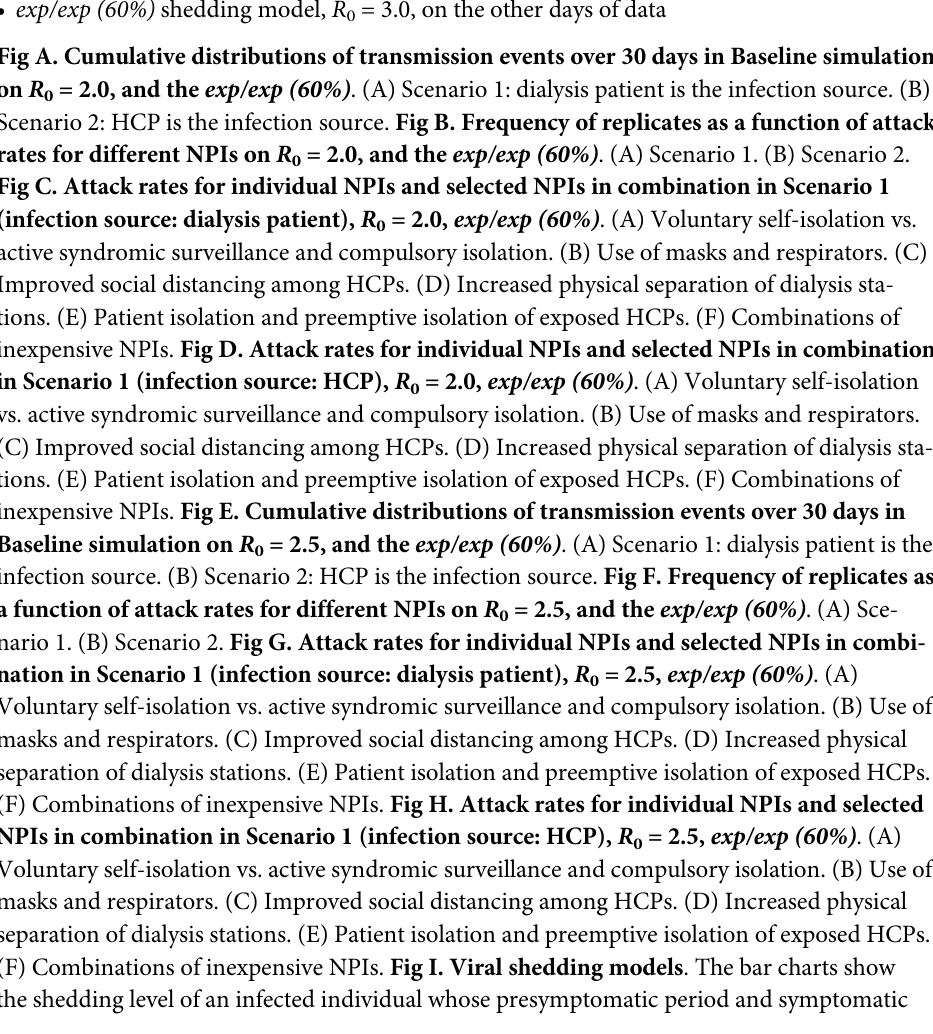
Fig A. Cumulative distributions of transmission events over 30 days in Baseline simulation on R = 2.0, and the exp/exp (60%) . (A) Scenario 1: dialysis patient is the infection source. (B) 0 Scenario 2: HCP is the infection source. Fig B. Frequency of replicates as a function of attack rates for different NPIs on R = 2.0, and the exp/exp (60%) . (A) Scenario 1. (B) Scenario 2. 0 Fig C. Attack rates for individual NPIs and selected NPIs in combination in Scenario 1 (infection source: dialysis patient), R = 2.0, exp/exp (60%) . (A) Voluntary self-isolation vs. 0 active syndromic surveillance and compulsory isolation. (B) Use of masks and respirators. (C) Improved social distancing among HCPs. (D) Increased physical separation of dialysis sta- tions. (E) Patient isolation and preemptive isolation of exposed HCPs. (F) Combinations of inexpensive NPIs. Fig D. Attack rates for individual NPIs and selected NPIs in combination in Scenario 1 (infection source: HCP), R = 2.0, exp/exp (60%) . (A) Voluntary self-isolation 0 vs. active syndromic surveillance and compulsory isolation. (B) Use of masks and respirators. (C) Improved social distancing among HCPs. (D) Increased physical separation of dialysis sta- tions. (E) Patient isolation and preemptive isolation of exposed HCPs. (F) Combinations of inexpensive NPIs. Fig E. Cumulative distributions of transmission events over 30 days in Baseline simulation on R = 2.5, and the exp/exp (60%) . (A) Scenario 1: dialysis patient is the 0 infection source. (B) Scenario 2: HCP is the infection source. Fig F. Frequency of replicates as a function of attack rates for different NPIs on R = 2.5, and the exp/exp (60%) . (A) Sce- 0 nario 1. (B) Scenario 2. Fig G. Attack rates for individual NPIs and selected NPIs in combi- nation in Scenario 1 (infection source: dialysis patient), R = 2.5, exp/exp (60%) . (A) 0 Voluntary self-isolation vs. active syndromic surveillance and compulsory isolation. (B) Use of masks and respirators. (C) Improved social distancing among HCPs. (D) Increased physical separation of dialysis stations. (E) Patient isolation and preemptive isolation of exposed HCPs. (F) Combinations of inexpensive NPIs. Fig H. Attack rates for individual NPIs and selected NPIs in combination in Scenario 1 (infection source: HCP), R = 2.5, exp/exp (60%) . (A) 0 Voluntary self-isolation vs. active syndromic surveillance and compulsory isolation. (B) Use of masks and respirators. (C) Improved social distancing among HCPs. (D) Increased physical separation of dialysis stations. (E) Patient isolation and preemptive isolation of exposed HCPs. (F) Combinations of inexpensive NPIs. Fig I. Viral shedding models . The bar charts show the shedding level of an infected individual whose presymptomatic period and